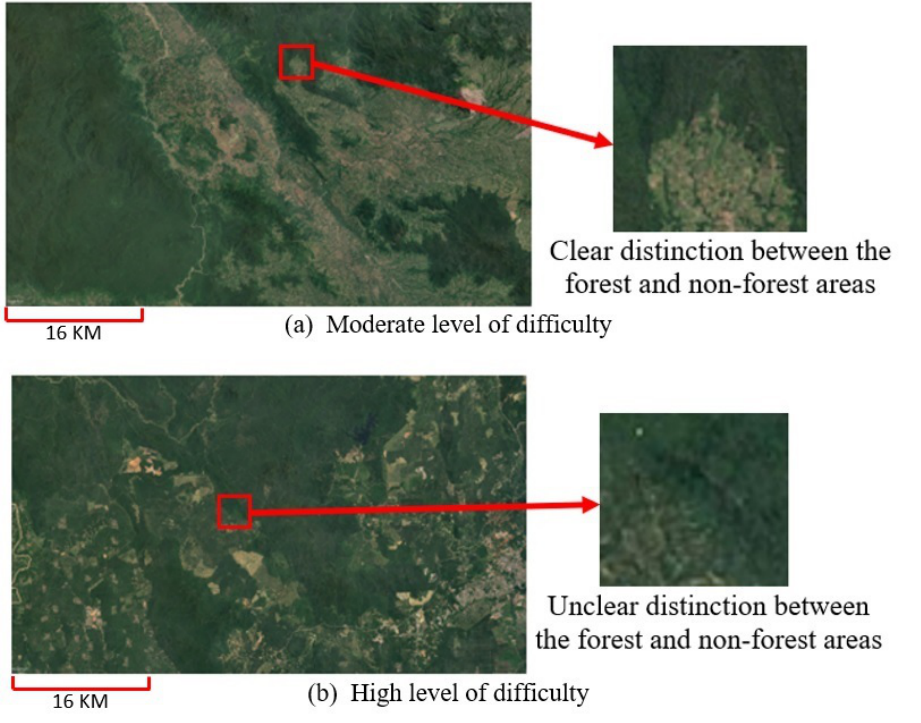
Figure 4. Satellite images from dataset of ( a , b ).